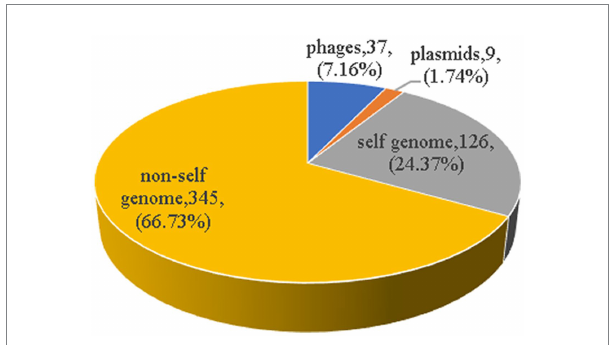
FIGURE 5 The homology analysis of spacer sequences. The homology of 517 spacer sequences in Enterococcus CRISPR was analyzed by BLAST alignment in GenBank. Nine (1.74%) were homologous to plasmids, 37 (7.16%) were homologous to phages, 126 (24.37%) targeted their own bacterial genomes, and 345 (66.73%) targeted non-self bacterial genomes.